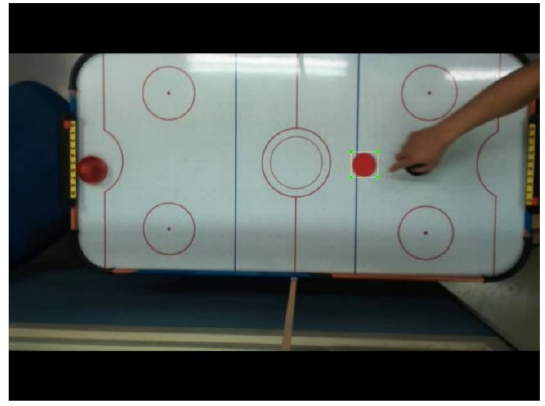
Figure 5. Image of hockey moving slowly.